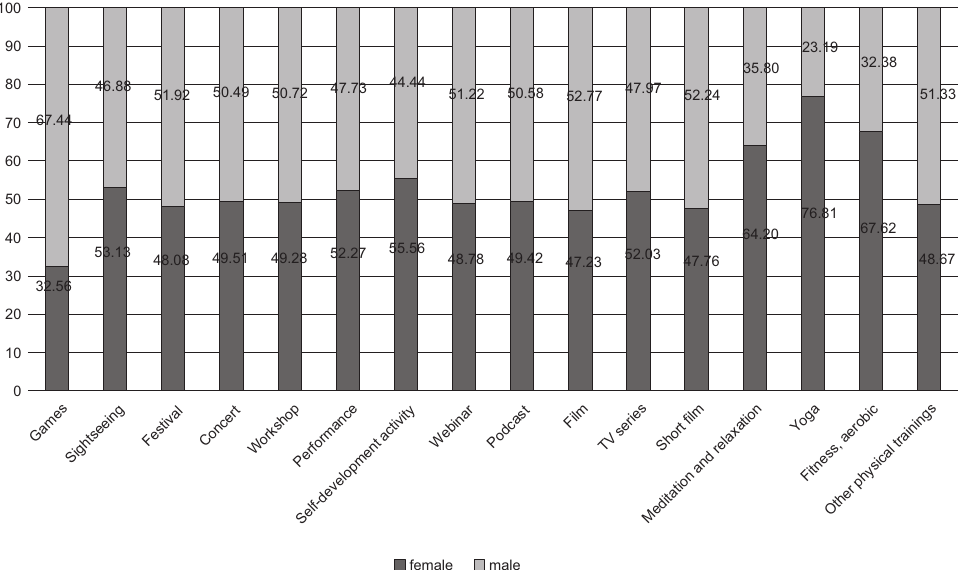
Fig. 5. The respondents’ willingness to continue computer-based entertainment after the coVId-19 pandemic, based on sex